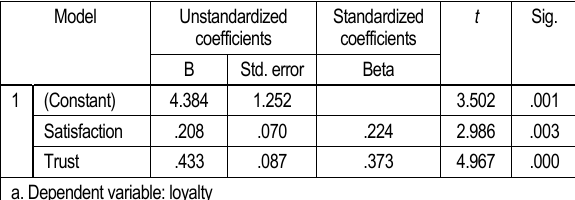
Table 8. Partial test ( t -test) of the fourth equation